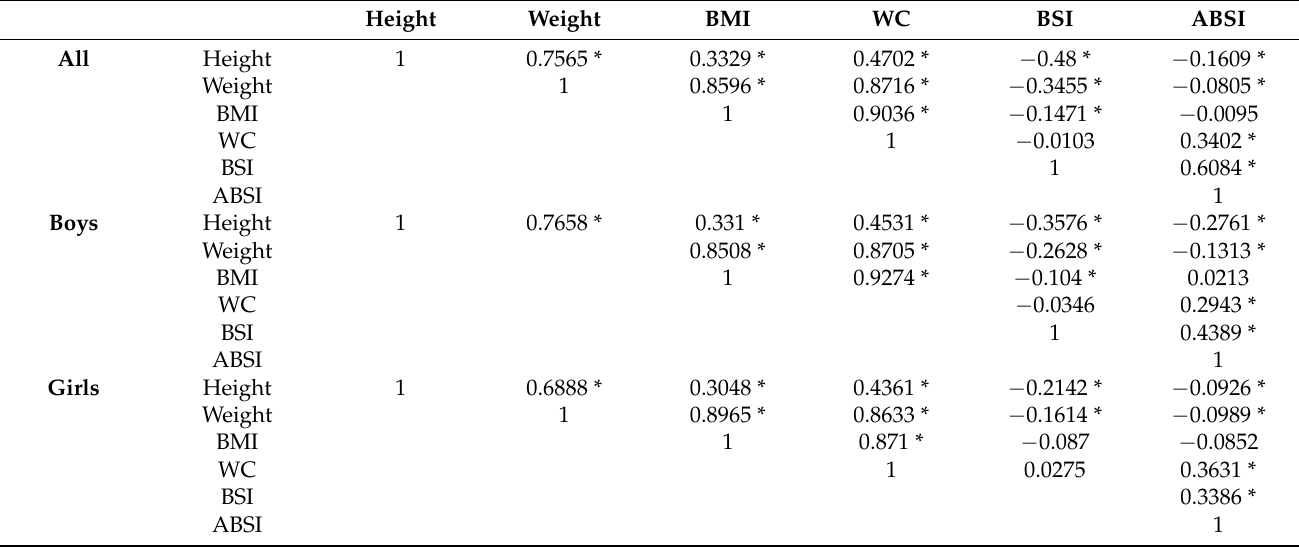
Table 4. Correlations among height, weight, BMI, WC, BSI, and ABSI in adolescents.